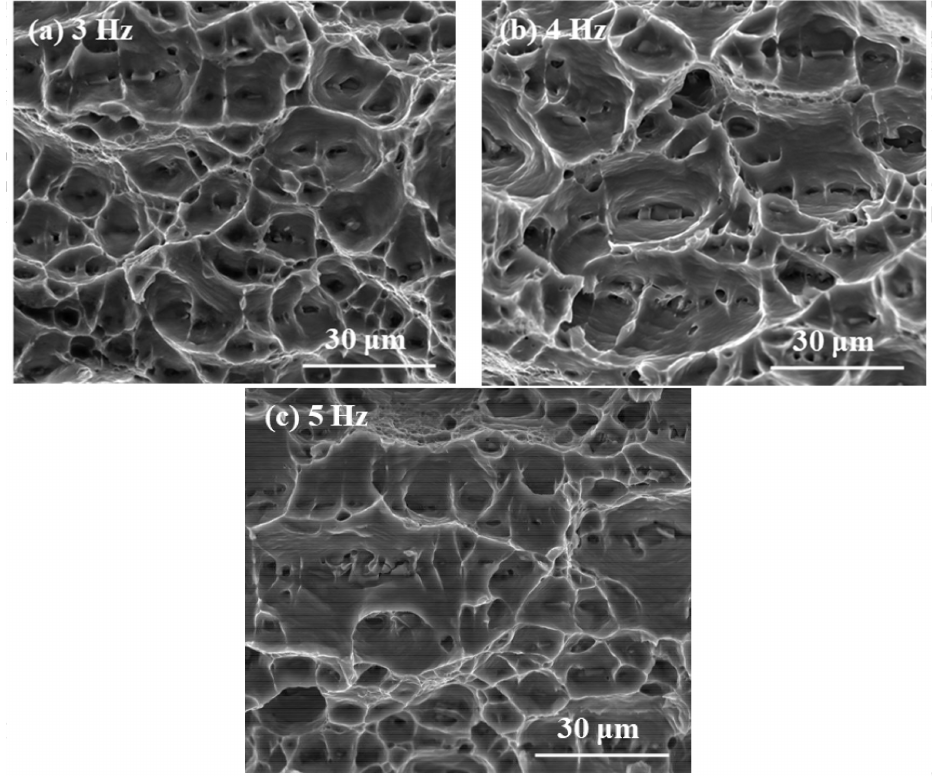
Figure 11. Photographs of fractured tensile